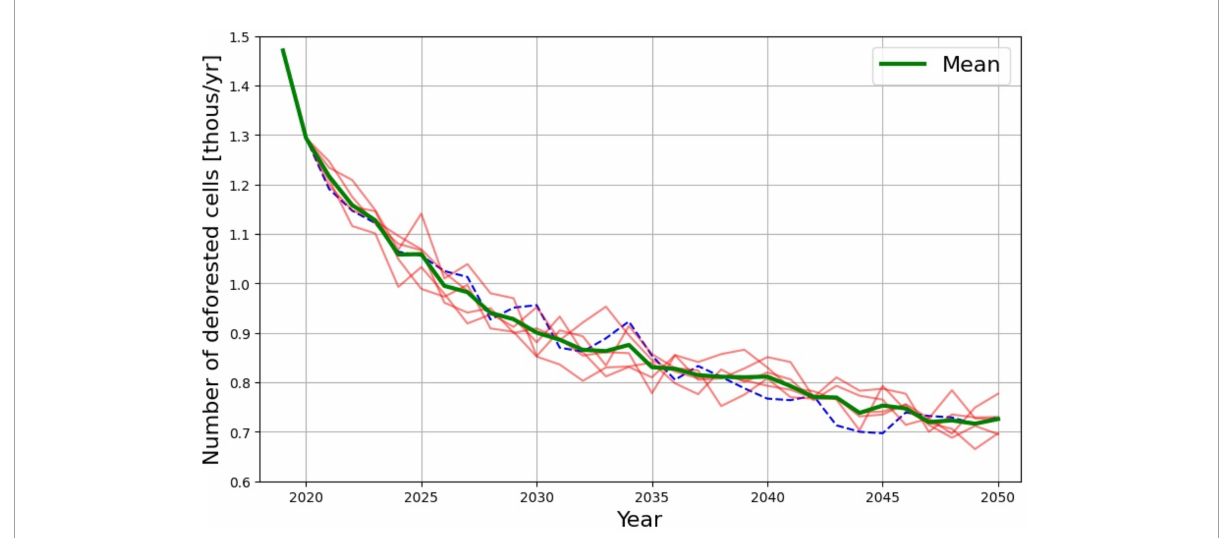
FIGURE6 Deforestation scenario with threshold N = 1. Deforestation rates are the number of deforested cells per year. The green line represents the mean of stochastic simulations. The dashed blue line represents a stochastic simulation used in the “Results” section. Other lines are representative of individual model runs. The spread of stochastic runs around the mean is bounded.